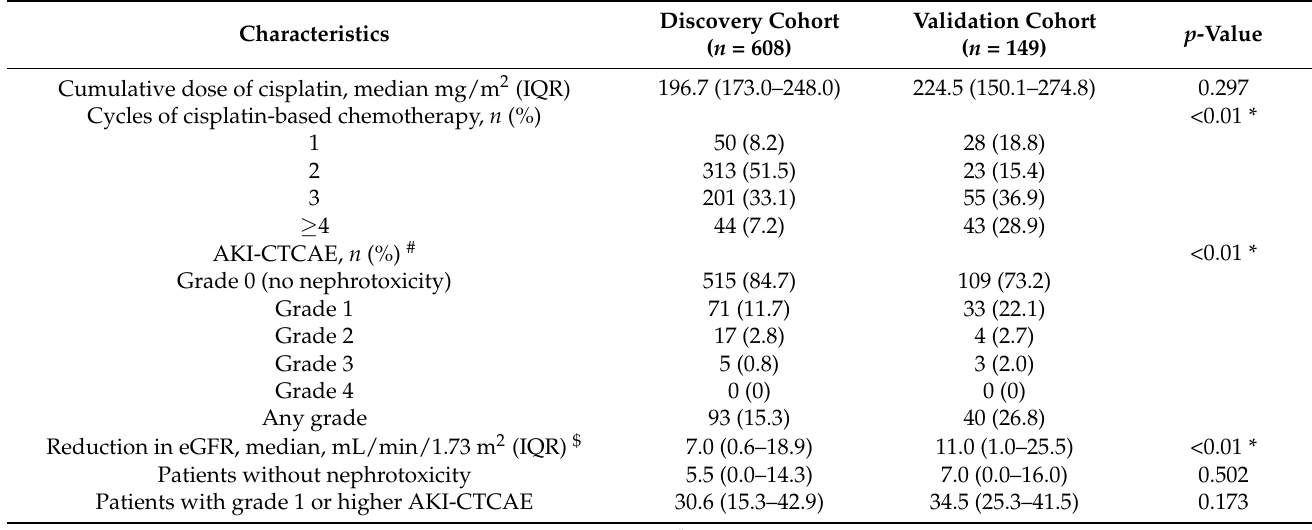
Table 2. Treatment characteristics and distribution of